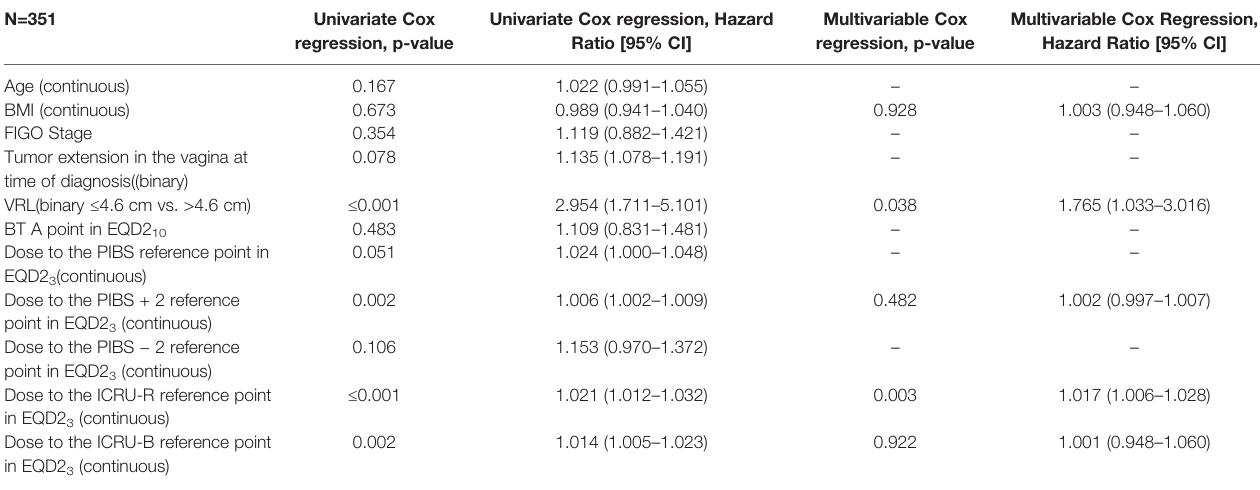
TABLE 3 | Univariate and multivariate analyses of risk factors for vaginal stenosis G ≥ 2.